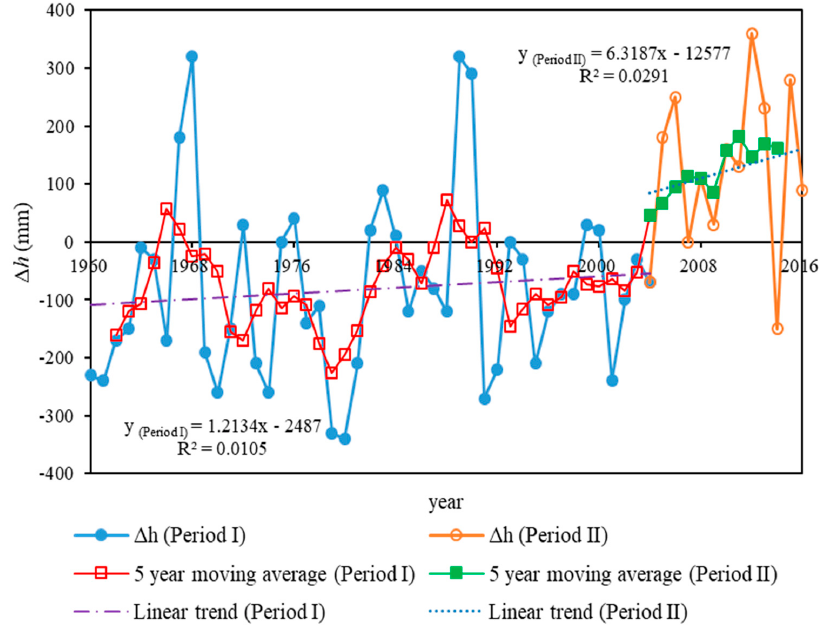
Figure 3. The trend of water level variation ( ∆ h ) during the period of 1960–2016.